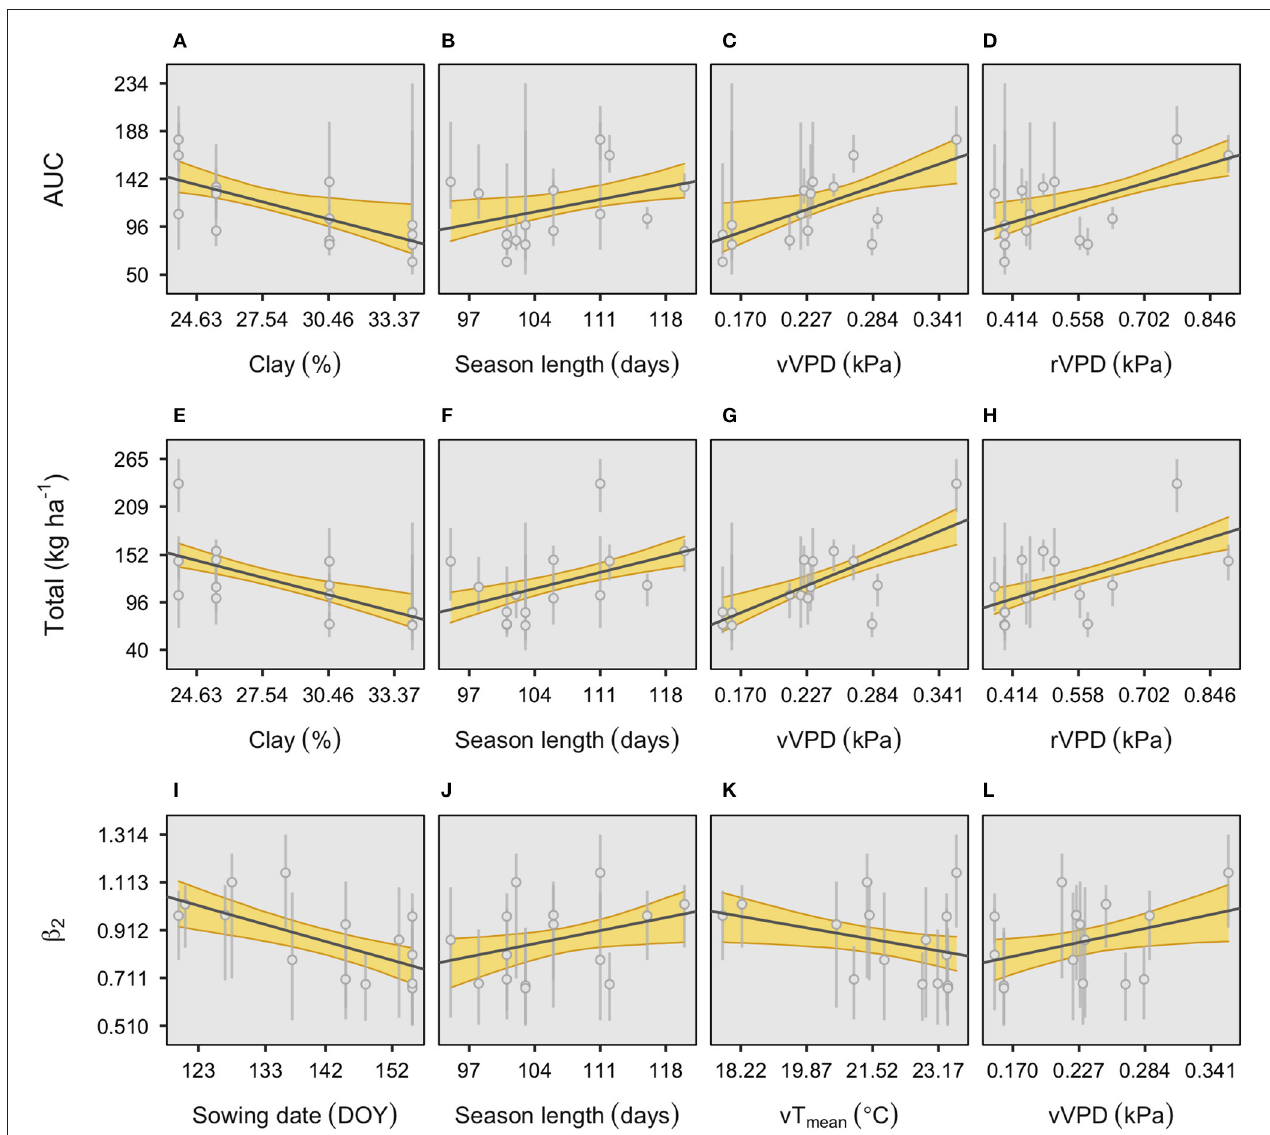
FIGURE 3 | Individual plots of the four environmental effects affecting the main parameters of the fixed-N response to relative phenology, descriptors of the area under the curve (A–D) , total fixed-N at maturity (E–H) , and time to maximum growth (ß2) (I–L) . The shaded area represents 95% credible intervals. Error bars represent the 95% credible interval of each parameter estimate. Further details on these variables and their units are presented in Table 2 . r, reproductive period (R1–R7); v, vegetative period (VE-R1, excluding flowering); VPD, vapor-pressure deficit, and T mean , mean